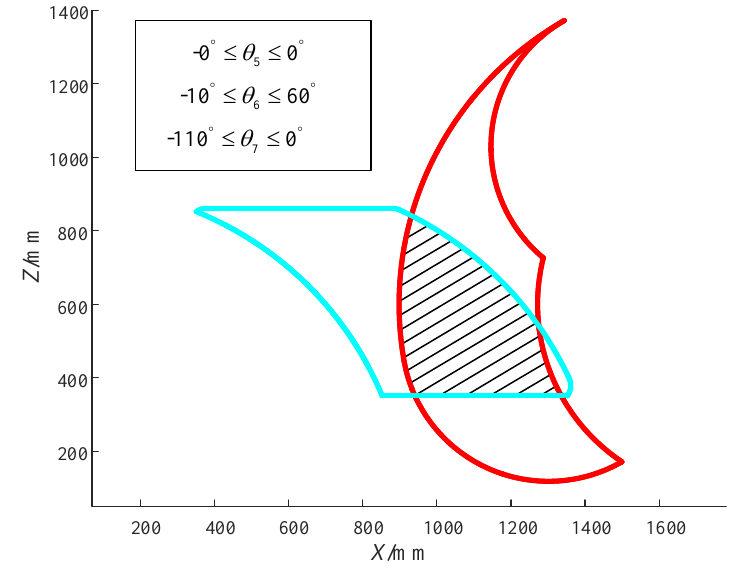
Figure 10. The variable human-robot workspace.